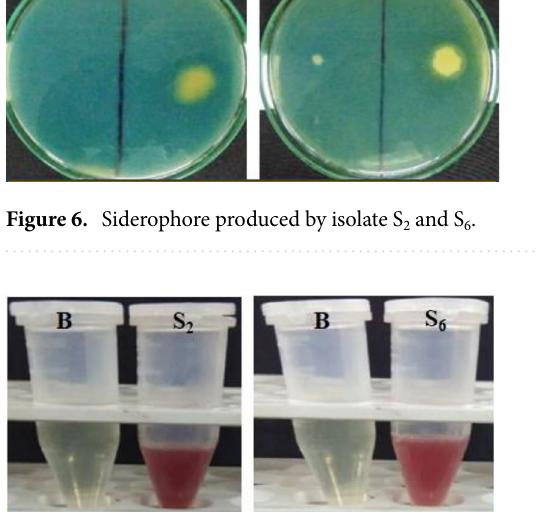
Figure 7. Tetrazolium test (Hydroxymate type Siderophore).